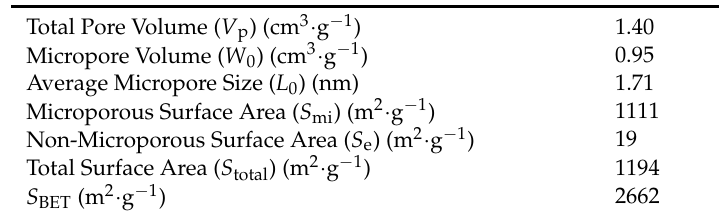
Table 2. Porosity features of the activated carbon.